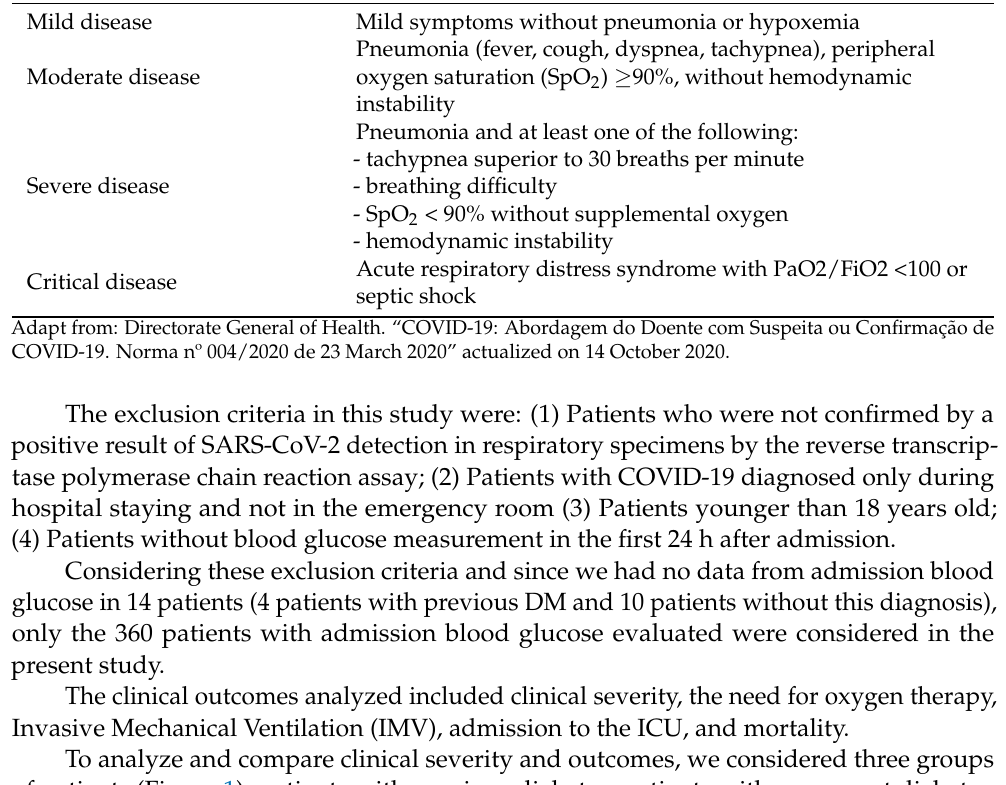
Table 1. Disease severity categories according to the Portuguese Directorate General of Health. COVID-19 Disease Severity